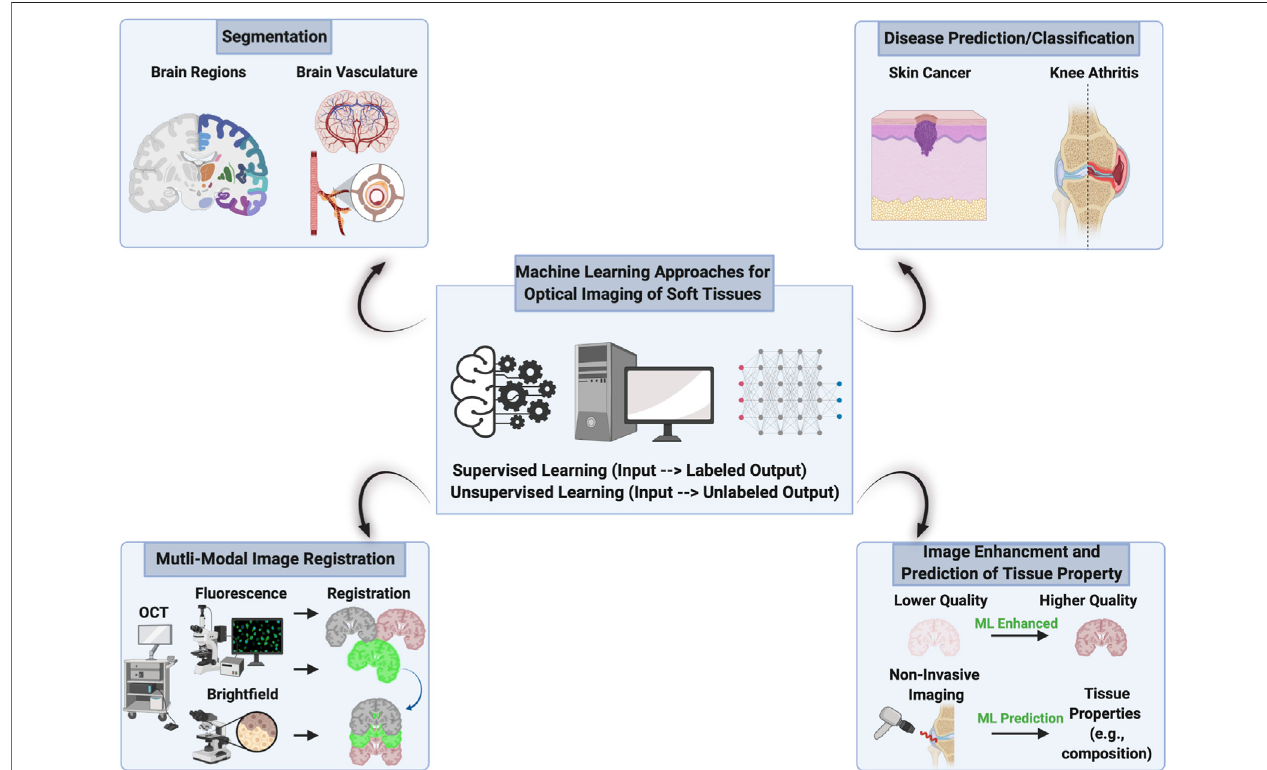
FIGURE4| Machinelearningapproachesforopticalimagingofsofttissues.Thisschematicsummarizessomeofthecurrentandnear-futureworkutilizingmachine learning (ML) approaches for optical imaging of soft tissues. These applications of ML are not limited to those shown and will likely increase diversity over time as more researchers expand into this fi eld. Created with